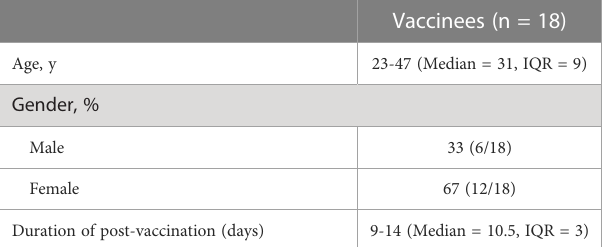
TABLE 1 Characteristics of donor